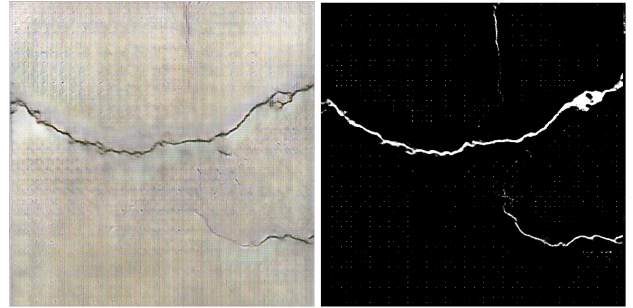
Figure 7. Sample images generated by DCGAN.